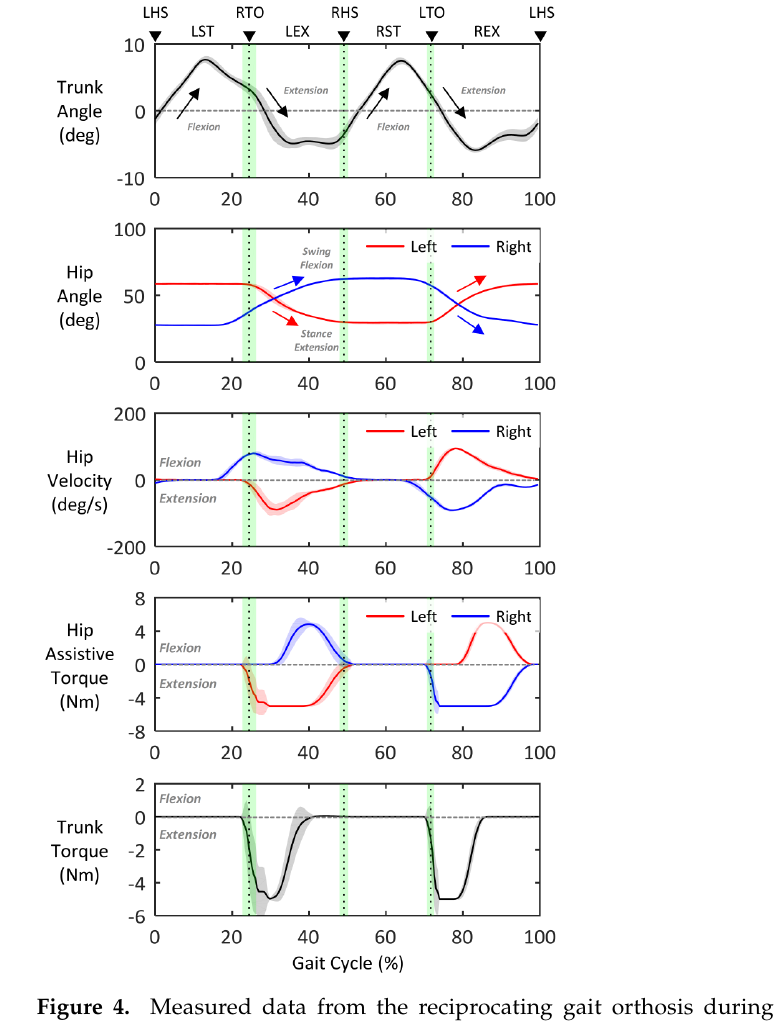
Figure 4. Measured data from the reciprocating gait orthosis during a gait cycle under the POWERED